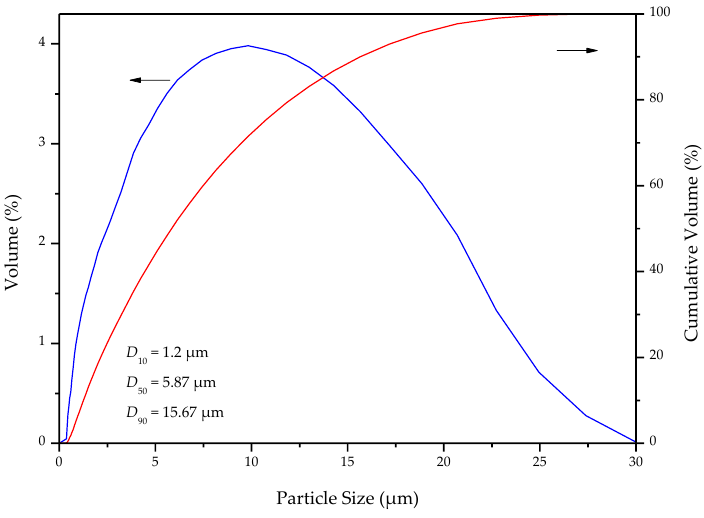
Figure 2. XRD pattern of calcinated KPFT (CKPFT).